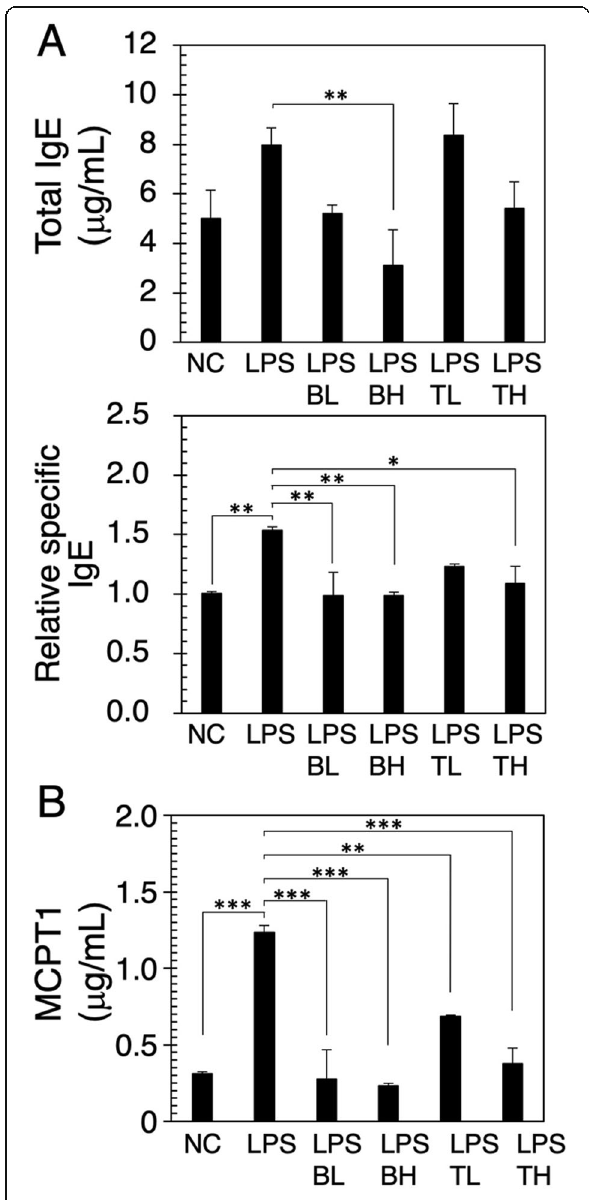
Fig. 5 Total IgE concentration, specific IgE level against OVM( a ) and MCPT-1 ( b ) concentration after challenge. At the end point, mice in OVM group were challenged OVM, 2 h later blood was collected from heart. Total IgE concentration, specific IgE level against OVM and MCPT-1 concentration were measured using ELISA.